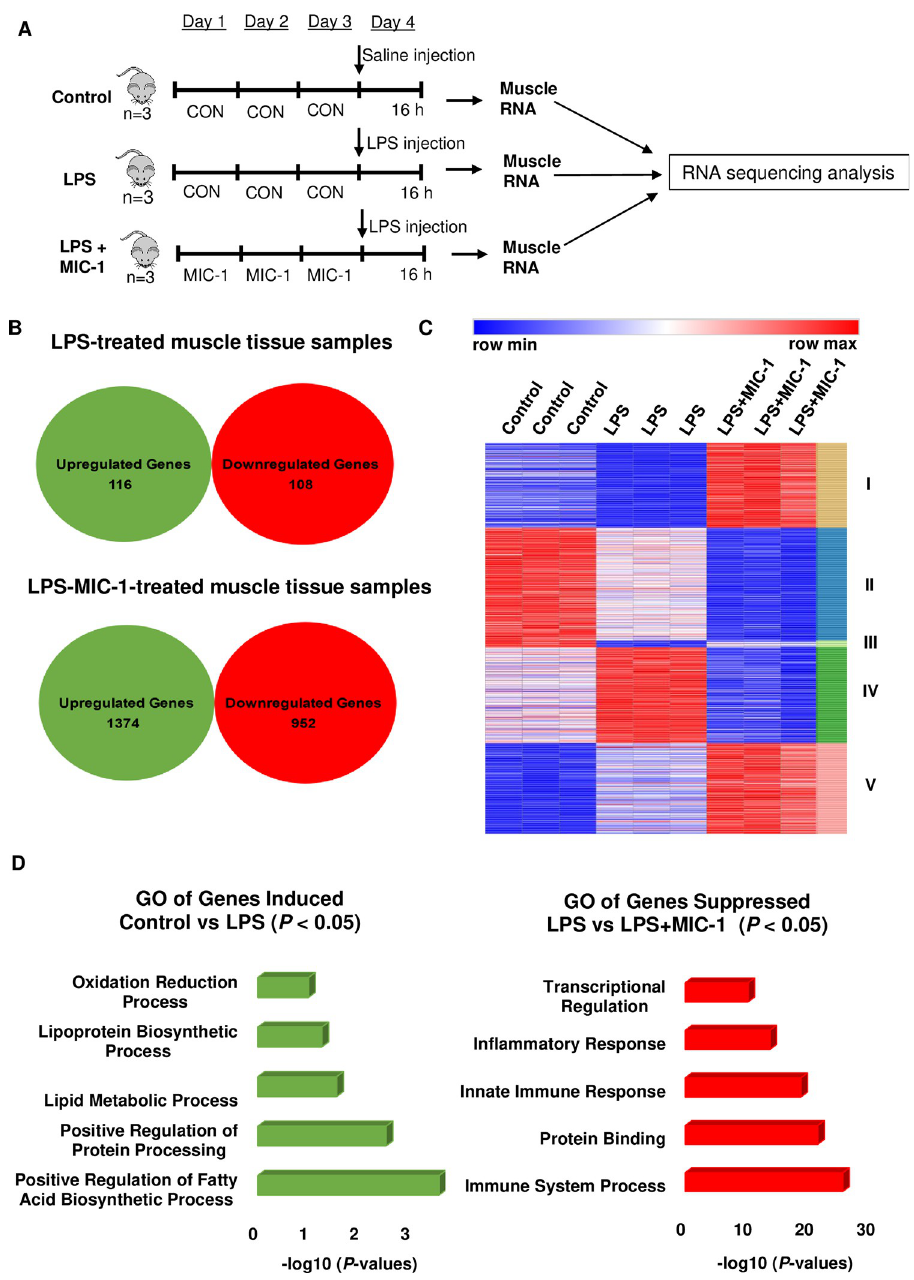
Fig 3. Transcriptome analysis of moringa isothiocyanate-1 (MIC-1) in muscle tissue. (A) Schematic diagram of the experimental protocol. MIC-1 was given orally daily for 3 days to C57BL/6 male mice before lipopolysaccharide (LPS) treatment. Mice were randomly divided into three groups: control (10% DMSO; p.o.); LPS (10 mg/kg bw; ip); LPS + MIC-1 (80 mg/kg bw; p.o.). Muscle tissues were collected 16 h after LPS treatment (n = 3). (B) Venn diagrams depict genes significantly (absolute log2-fold change > 1; P < 0.05) upregulated/downregulated due to LPS (control vs. LPS- treated samples) or MIC-1 (LPS-treated samples vs. LPS-MIC-1-treated samples) in murine gastrocnemius tissues. (C) Heat map of differentially expressed genes in five k-means clusters. Column, row, and color represent a sample, gene, and expression level, respectively. (D) Gene ontology (GO) analysis of upregulated genes due to LPS (control vs. LPS- treated samples), and downregulated genes due to MIC-1 (LPS-treated samples vs. LPS-MIC-1-treated samples), represented as negative log10 ( P -values).